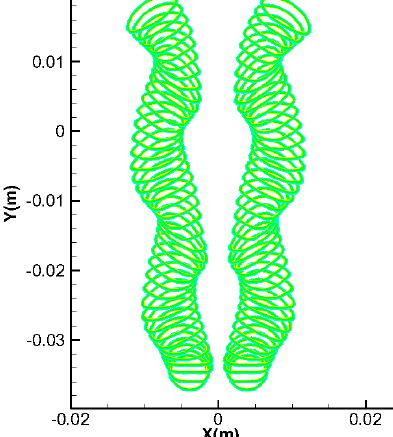
Figure 12. Bubble rising trajectory obtained from simulation.